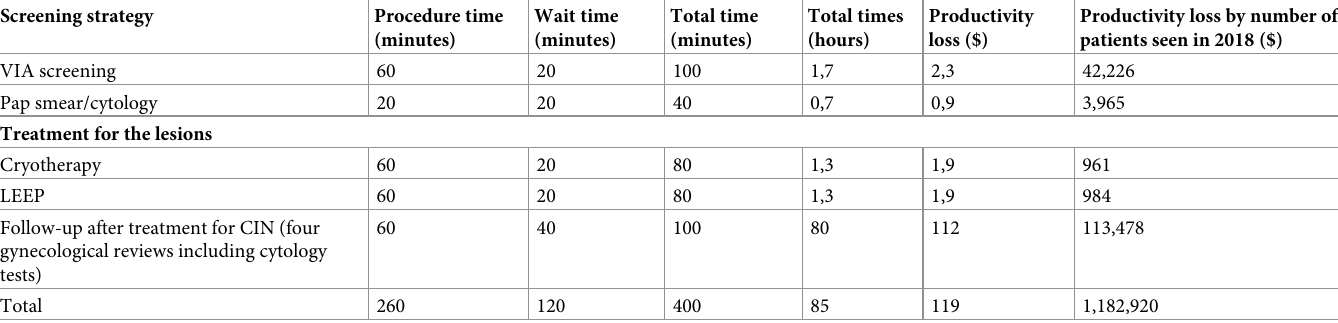
Table 6. Assumed patient time spent and productivity lost by screening methodology, diagnosis and treatment of CIN. Screening